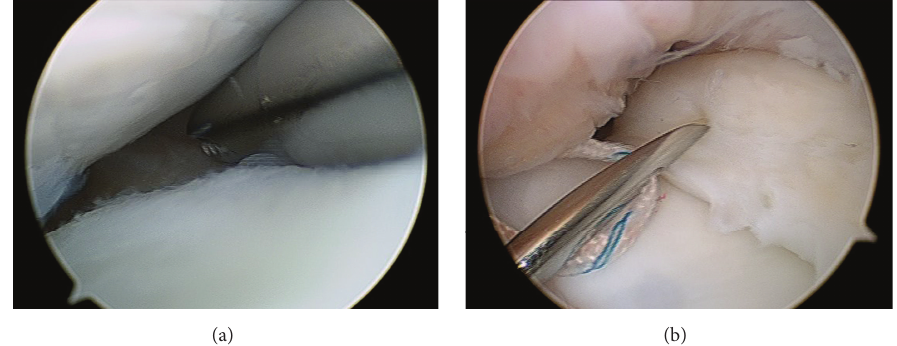
Figure 3: Arthroscopic image of the medial femorotibial compartment of the right knee from the anterolateral portal. (a) Refreshment of the tear with a shaver. (b) Inside-out suture technique of the tear with a specific device.